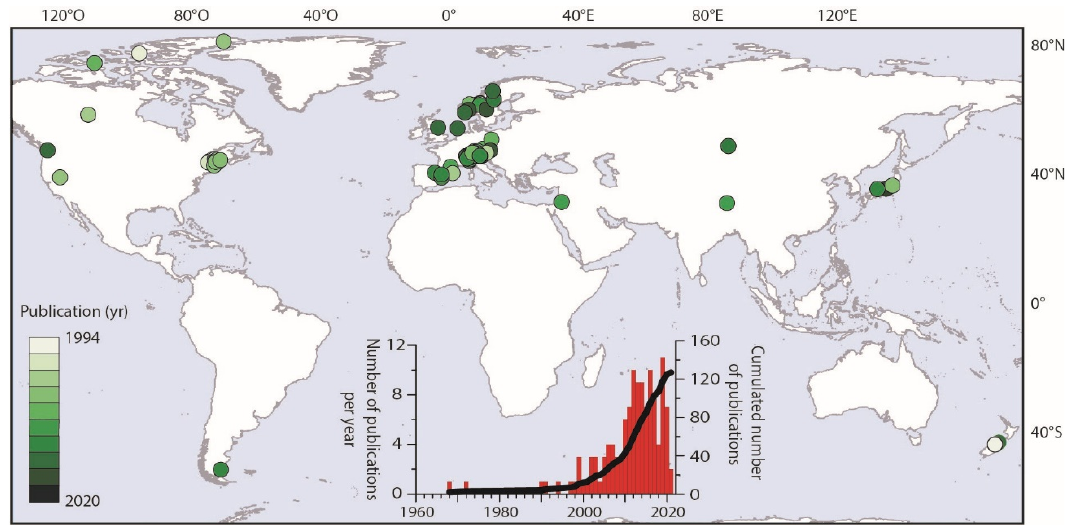
Figure 1. Map of the published paleoflood records from lake sediments and chronology of publica- tions covering all aspects of paleoflood hydrology from lake sediments (a publication in 1885 has been omitted for graphic reasons). A complete list of the published paleoflood records is available in Supplementary